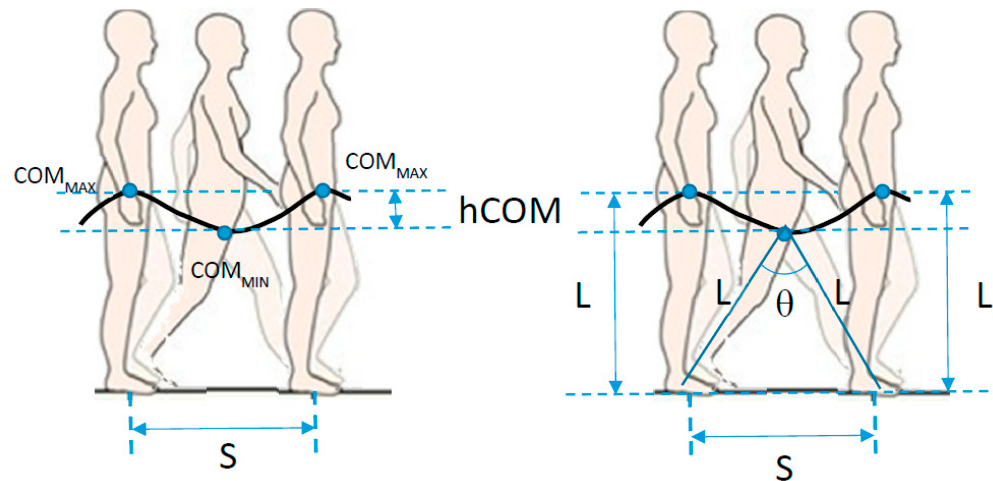
Figure 3. Walking pattern of the sinusoidal oscillation of the COM (Center of Mass) projected onto the sagittal plane of a single gait cycle. L is the length of the rigid lower limb; θ is the hip angle of the step. The maximum amplitude of COM oscillation is hCOM. Circles highlight COM maximum/minimum positions in the trajectory.